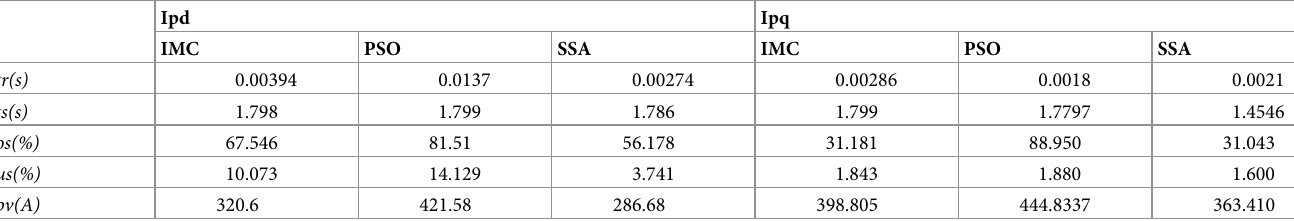
Table 5. PW current values for d and q